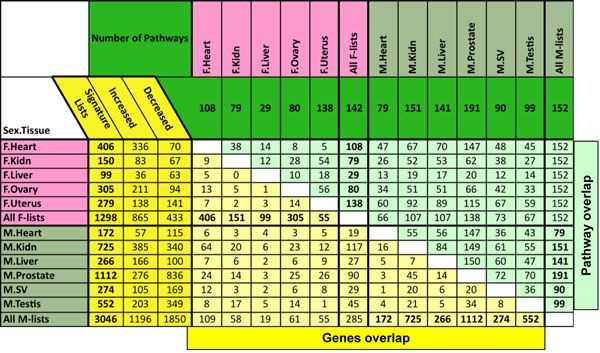
Number of differentially expressed genes and pathways that overlap between signature
lists. The total number of genes or pathways for a signature list is shown in bold and only
pathways with three or more affected genes are counted. F, female; M, male; SV, seminal vesicle.